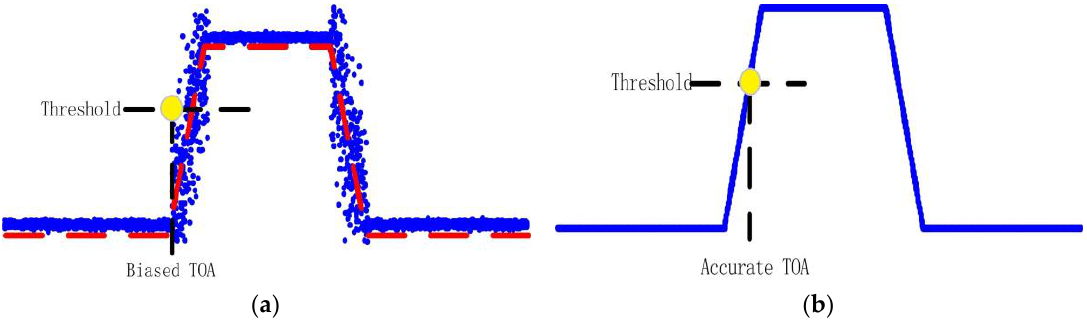
Figure 4. TOA measurement principle ( a ) noise-corrupted case ( b ) noise-free case.